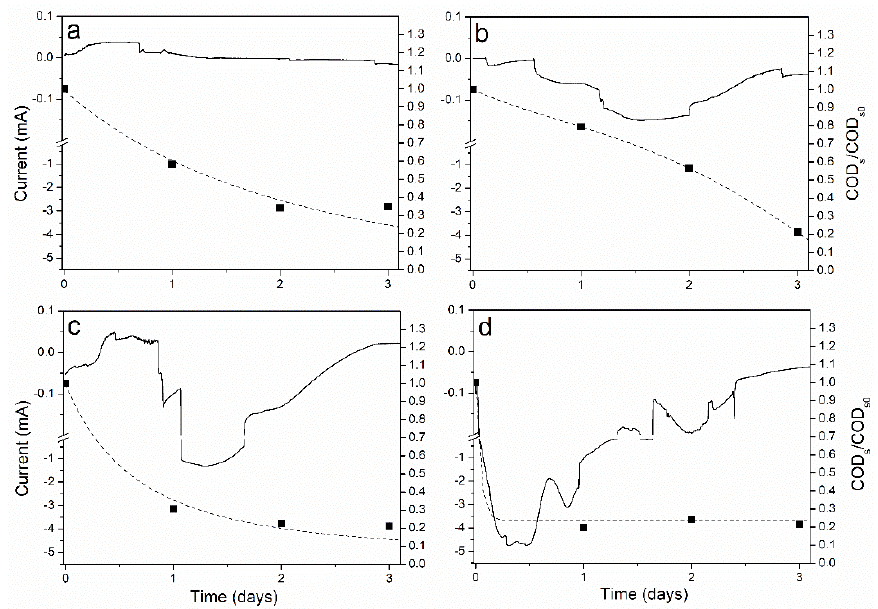
Figure 3. Cronoammperograms (black continuous line) and time course of normalized soluble chemical oxygen demand (COD) (black dash line) at different voltages: −0.2 V ( a ), −0.4 V ( b ), −0.6 V ( c ) and −0.8 V ( d ).